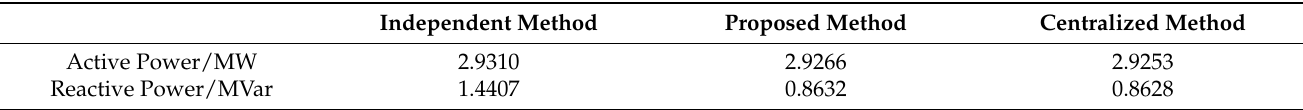
Table 7. Power transmitted from TSO to D26 with different methods on test case 1.